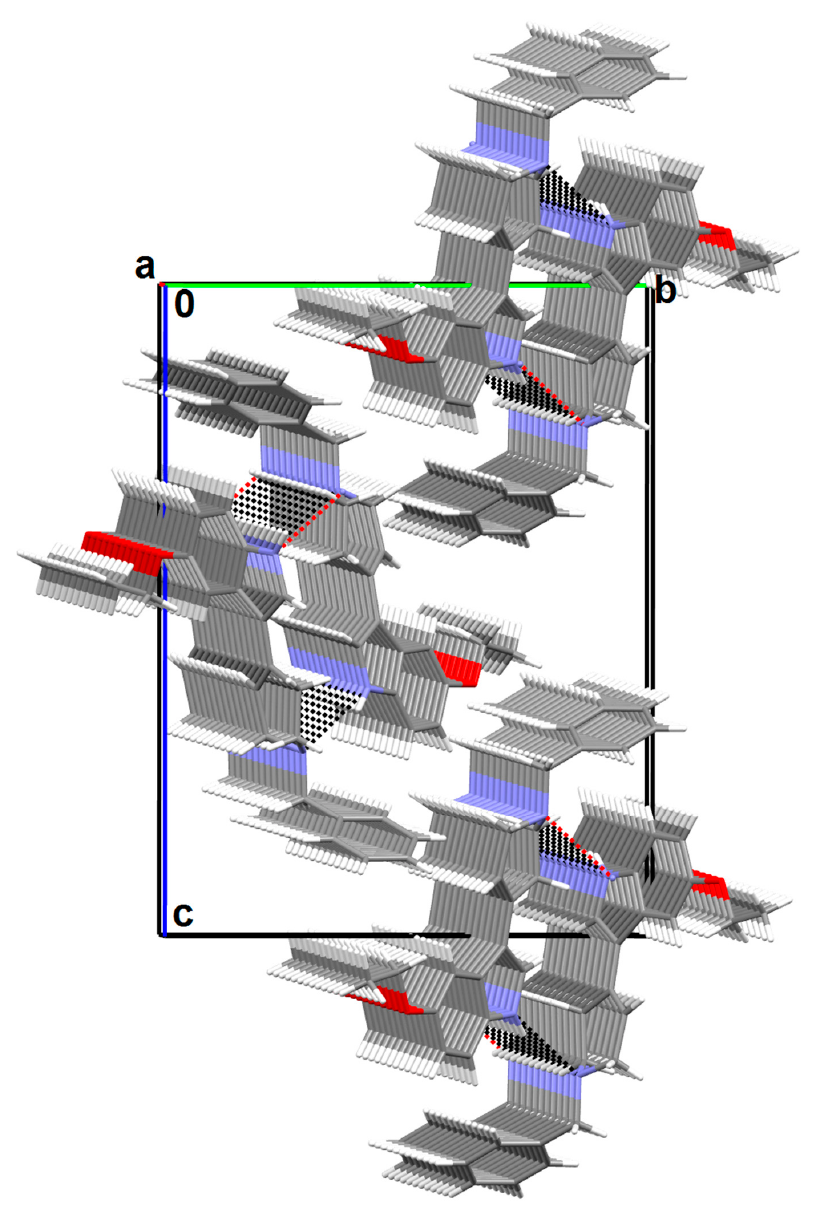
Figure 4. Fragment of the crystal structure of D2AAK1_3 showing formation of one-dimensional columns viewed along the a -axis.